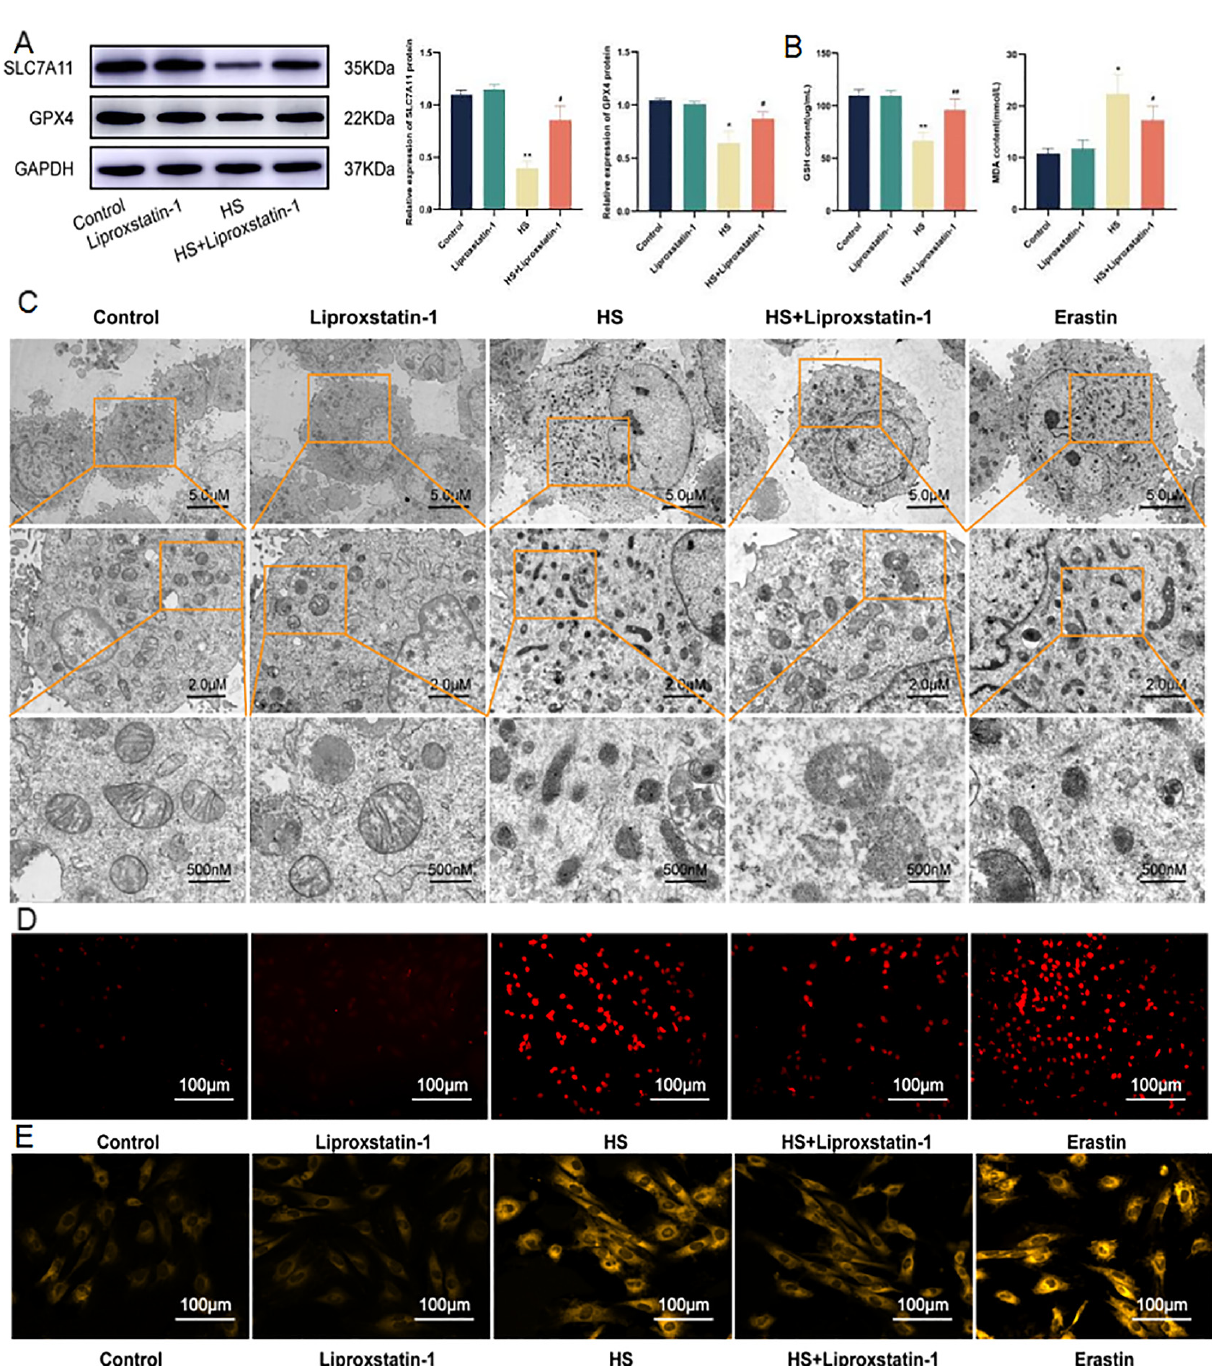
Figure 3. Liproxstatin-1 ameliorates ferroptosis induced by HS. The protein expression of SLC7A11 and GPX4 in H9C2 cells ( A ). GSH and MDA contents in H9C2 cells ( B ). Image of mitochondrial structure of H9C2 cells at 1200×, 2000×, or 10,000× magnification croscope. Scale bars = 5 µm, 2 µm and 500 nm ( C ). ROS level in H9C2 cells. Scale bars = 100 µm ( D ). Fe 2+ level in H9C2 cells. Scale bars = 100 µm ( E ). The results were expressed as the mean ± SD deviation of three independent experiments. * p < 0.05, ** p < 0.01 vs. the control group; # p < 0.05, ## p < 0.01 vs. the HS group.